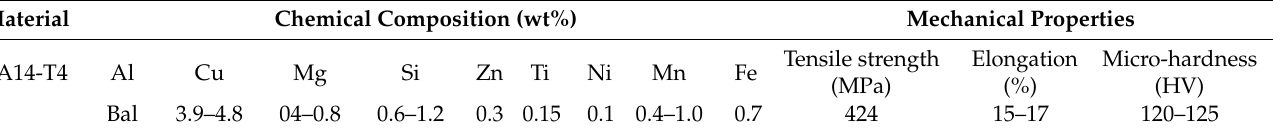
Table 1. Chemical composition range and mechanical properties of 2A14 aluminum